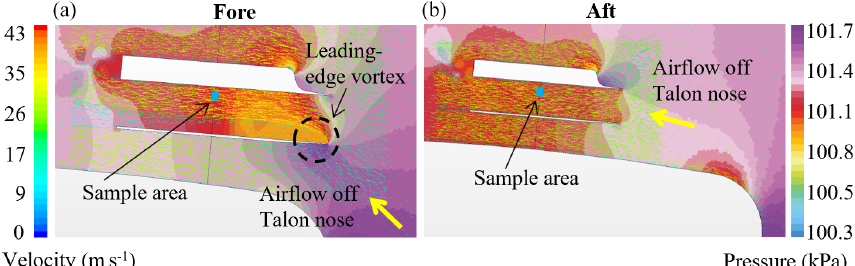
Figure 4. A plot of the pressure and velocity fields of the fore and aft simulations, with an AoA of 0 ◦ . The fore simulation results are shown in (a) , and the aft results are shown in (b) . The colour of the background is the absolute pressure of the continuum, and the colour and direction of the glyphs show the velocity field. The dashed black circle indicates a leading-edge vortex at the UCASS inlet in the fore simulation, the blue square indicates the UCASS sample volume, and the yellow arrow shows the airflow direction at the UCASS